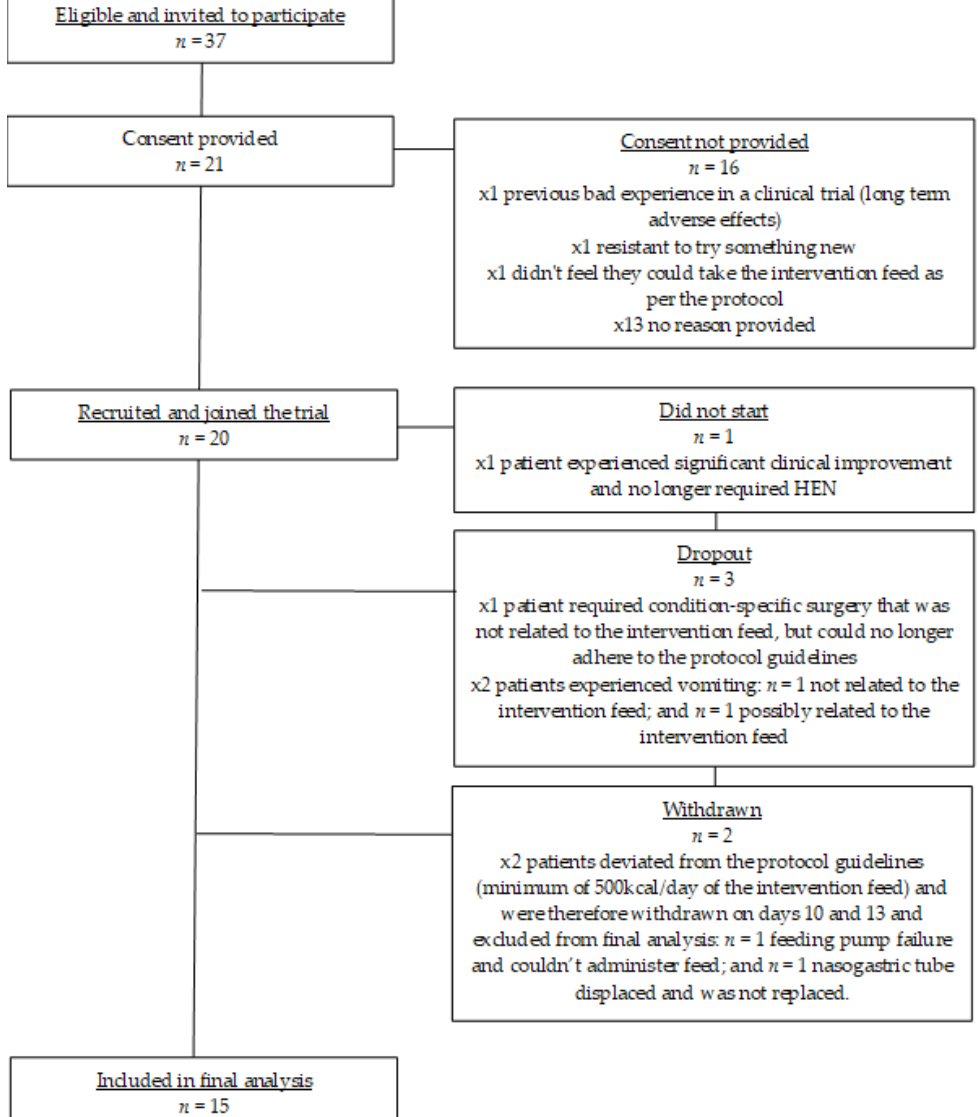
Figure 1. Flow chart of trial participation and exclusions.